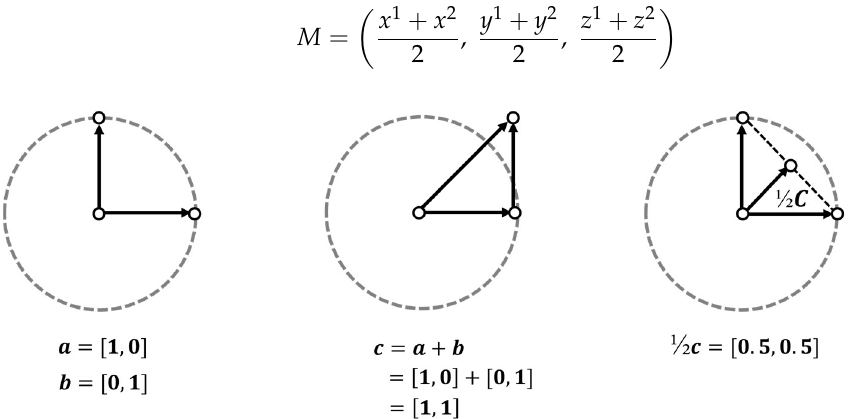
Figure 12. Procedure of finding midpoints of two points.